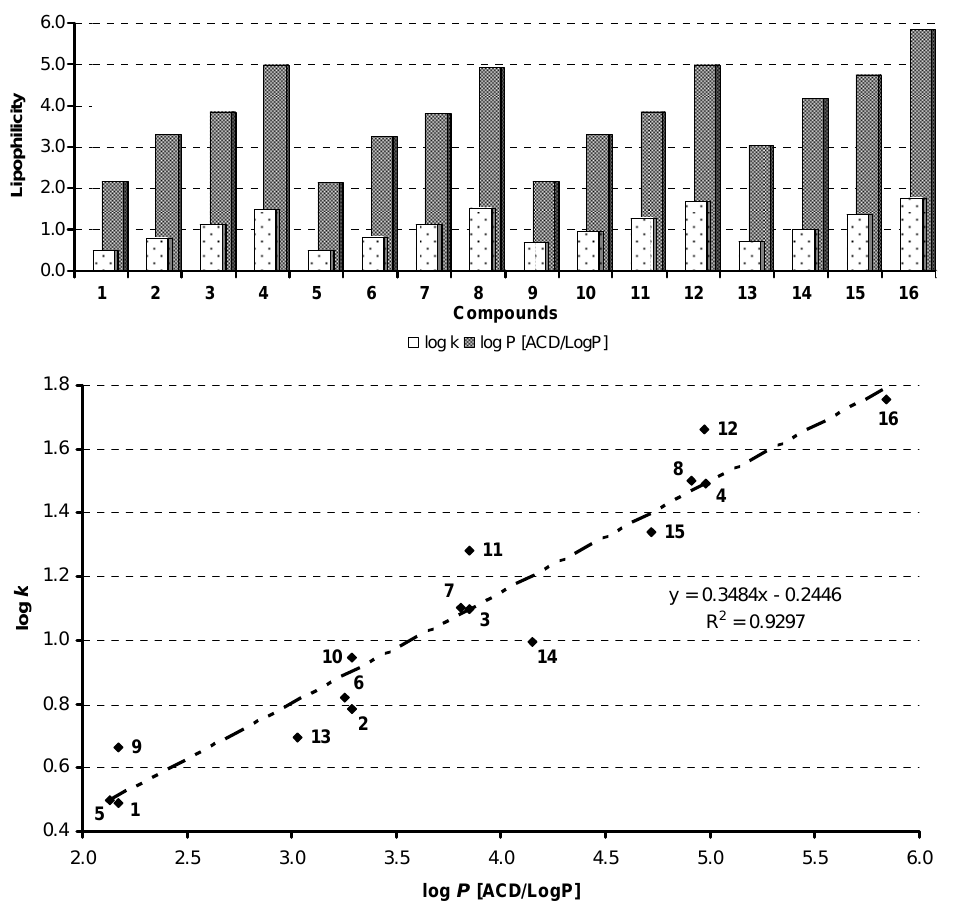
Figure 2. Match of the calculated log P data with the experimentally found log k